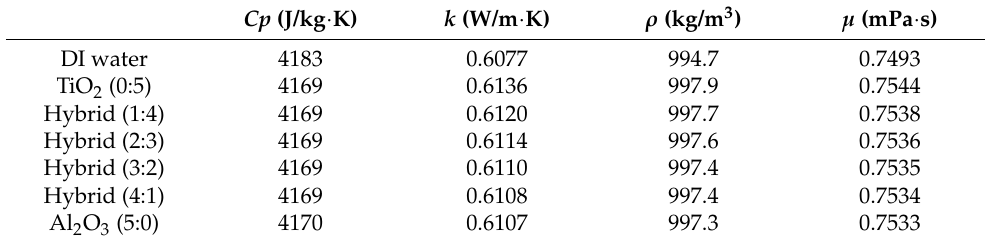
Table 9. Thermo-physical properties of fluids at 25 ◦